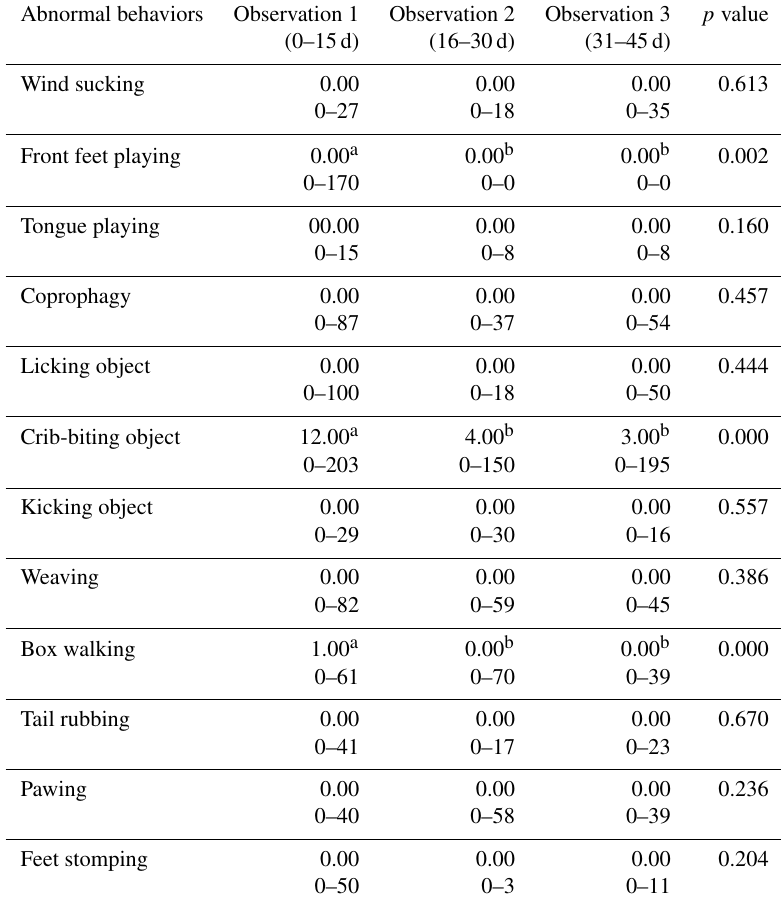
Table 4. Consequences of abnormal behaviors in observation periods (median / daily amount − min–max). The p values refer to the effect of difference between observation periods; within each row, different superimposed letters indicate significant differences between observation